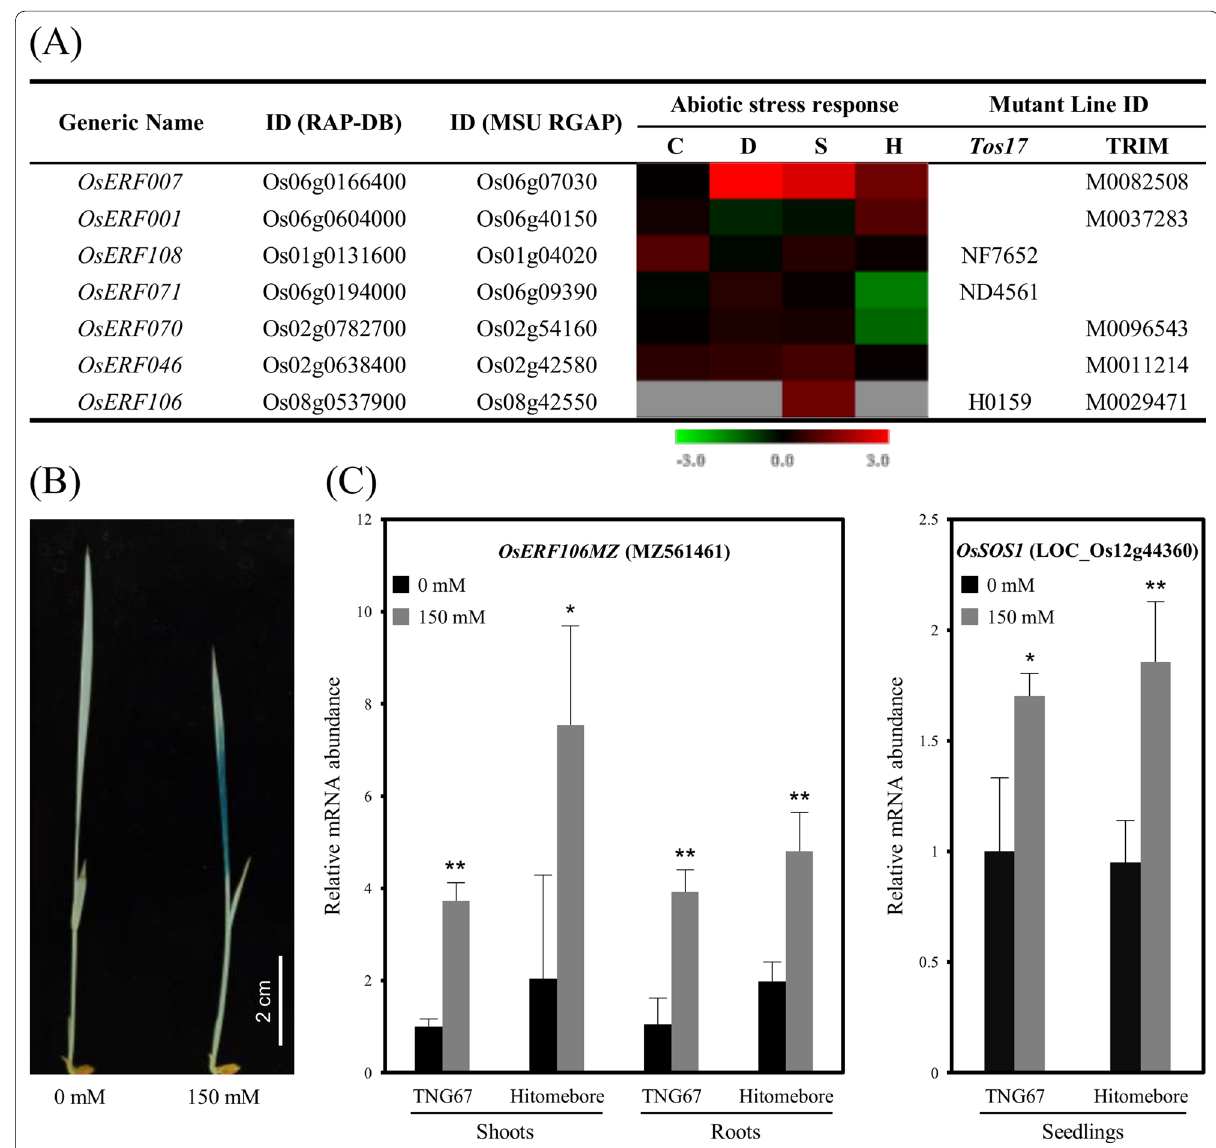
Fig. 1 NaCl‑enhanced OsERF106MZ expression. a Abiotic stress‑responsive OsERFs . Red and green indicate increased and decreased gene expression, respectively. The scale bar shows log 2 ‑fold changes. C, cold stress; D, drought stress; S, salinity stress; H, heat stress. Tos17 , Rice Tos17 Insertion Mutant Database; TRIM, Taiwan Rice Insert Mutant Database. b Histochemical staining of the shoots in OsERF106MZp::GUS transgenic seedlings. c Quantification of OsERF106MZ and OsSOS1 mRNA levels in Tainung 67 (TNG67) and Hitomebore seedlings by qPCR. The values are the mean SE of five biological replicates, each with two technical replicates. Asterisks indicate significant differences (* P < 0.05 and ** P < 0.01) based ± on Student’s t ‑test. The seedlings used for the GUS staining ( b ) and qPCR ( c ) assays were grown on basal medium for 7 days and then transferred to basal medium containing 0 or 150 mM NaCl for an additional